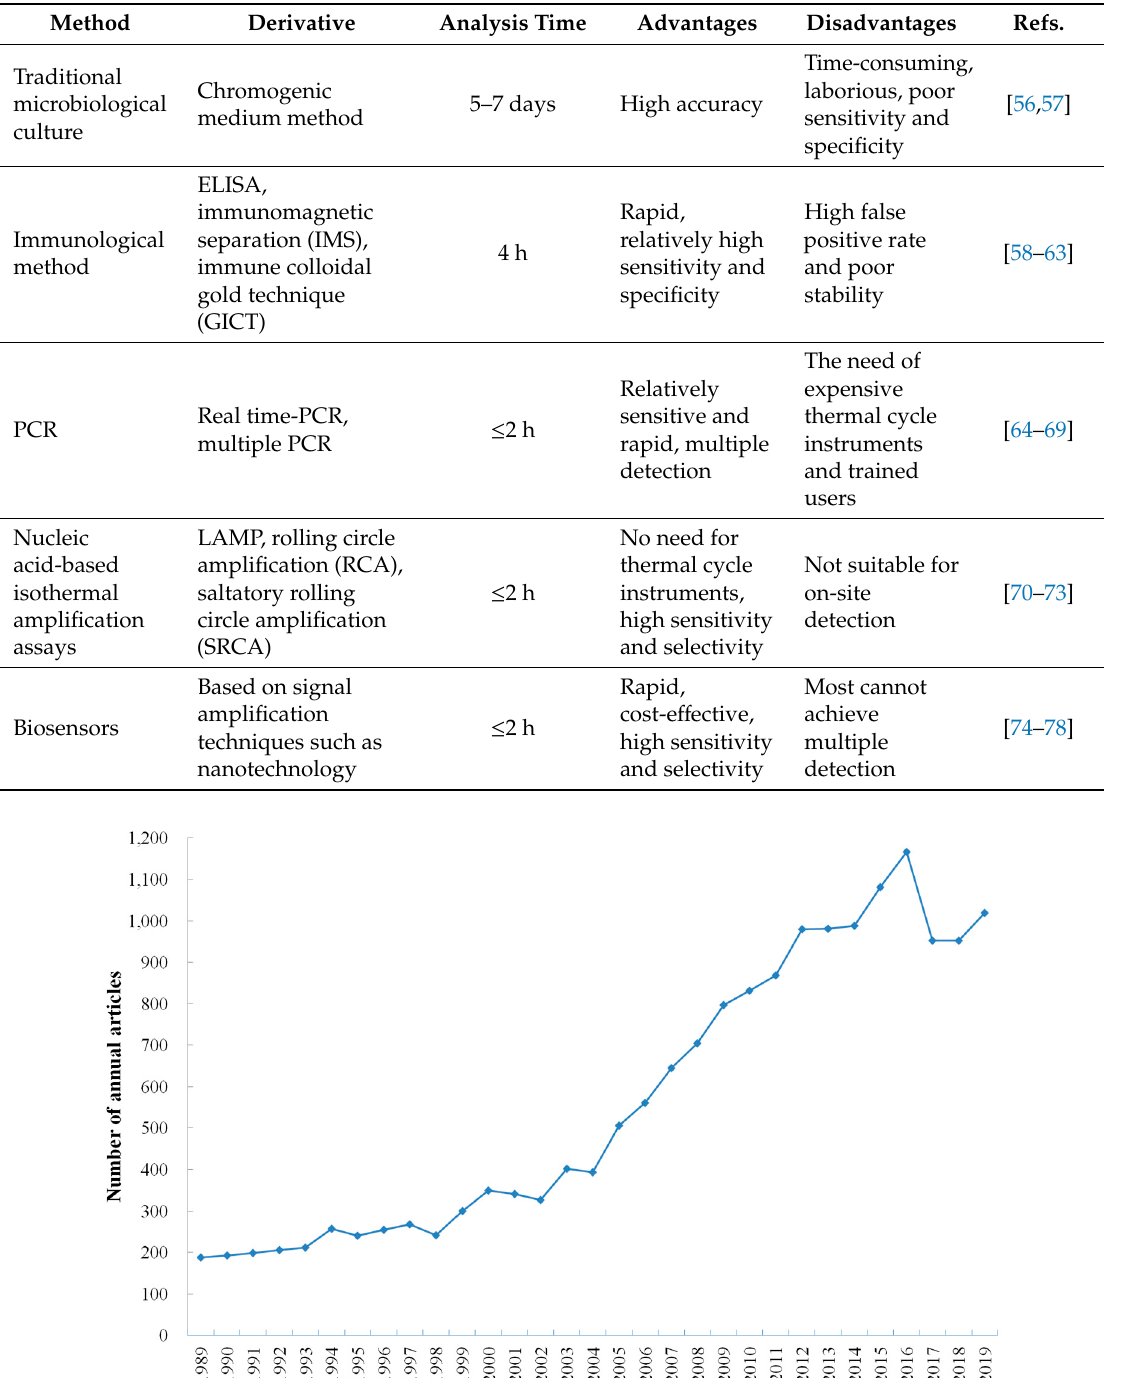
Table 2. Current methods for food-borne pathogens detection.